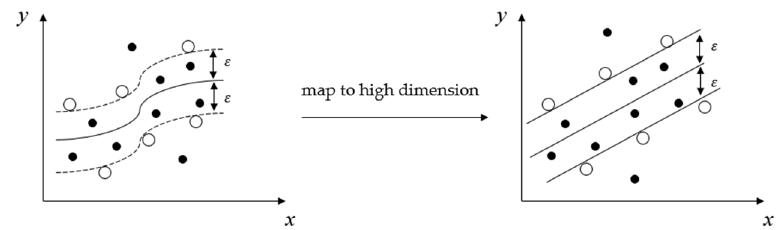
Figure 2. Schematic digamma of the kernel trick.